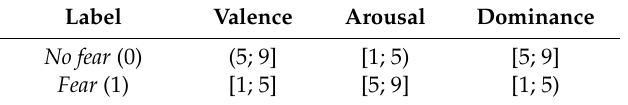
Table 1. Division of valence, arousal and dominance for the two-level fear evaluation modality. Label